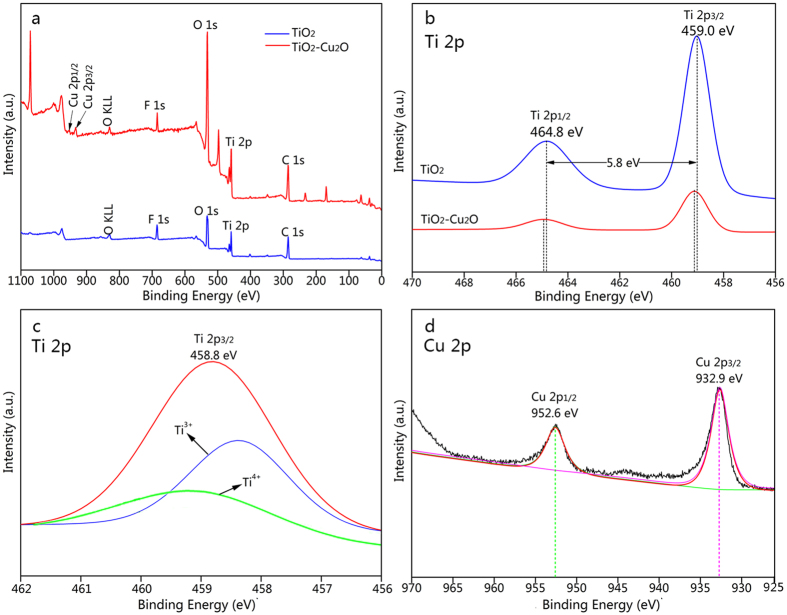
(a) Survey scan and (b) Ti 2p XPS spectra of the TiO2-treated wood and the TiO2/Cu2O-treated wood, (c) peaking-fitting results of Ti 2p XPS spectra of the TiO2/Cu2O-treated wood after UV light irradiation, (d) Cu 2p XPS spectra of the TiO2/Cu2O-treated wood.